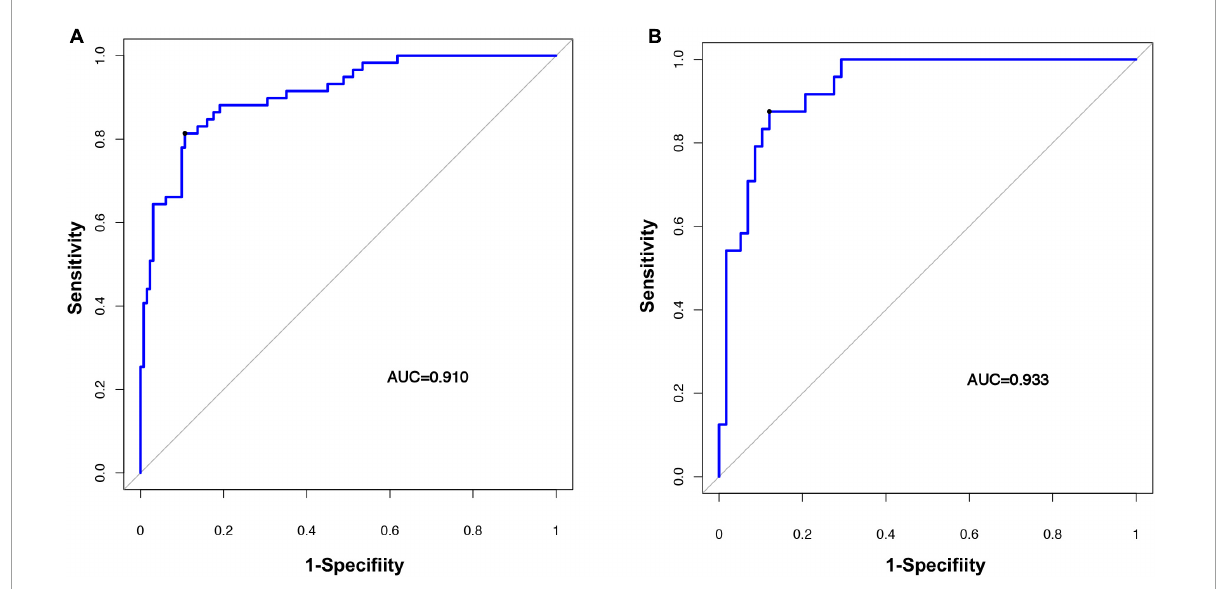
FIGURE6 Evaluating the accuracy of the radiomic nomogram. The training cohort (A) and the validation cohort (B) were used to evaluate how accurately the radiomic nomogram predicted fSAD (AUC = 0.910 and 0.933, respectively). AUC, area under the receiver-operator characteristic (ROC) curve; fSAD, small airway dysfunction.